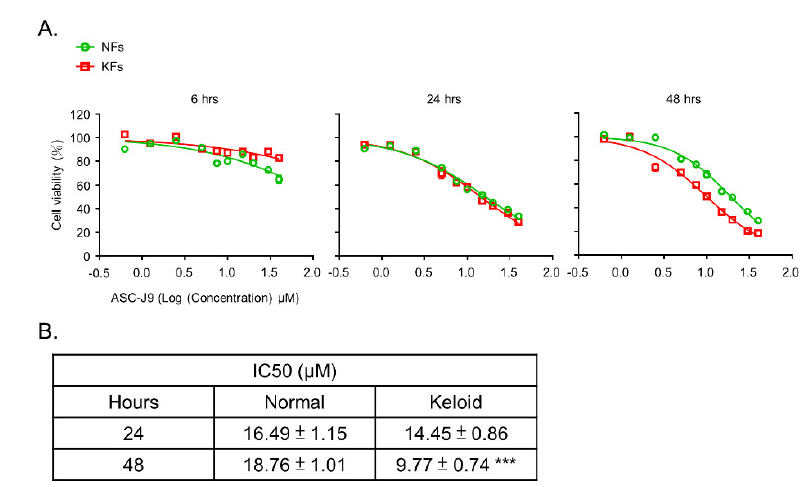
Figure 2. The inhibitory effect of ASC-J9 on the proliferation of normal fibroblasts and keloid fibroblasts. ( A ) The cell viability (%) of NFs ( n = 3) and KFs ( n = 3) treated with ASC-J9 for 6, 24, or 48 h was examined by MTT assays. ( B ) IC50 values at 24 or 48 h in NFs and KFs are shown. NFs, normal fibroblasts; KFs, keloid fibroblasts. *** p < 0.001. P -values were determined by unpaired two-tailed Student’s t -test.